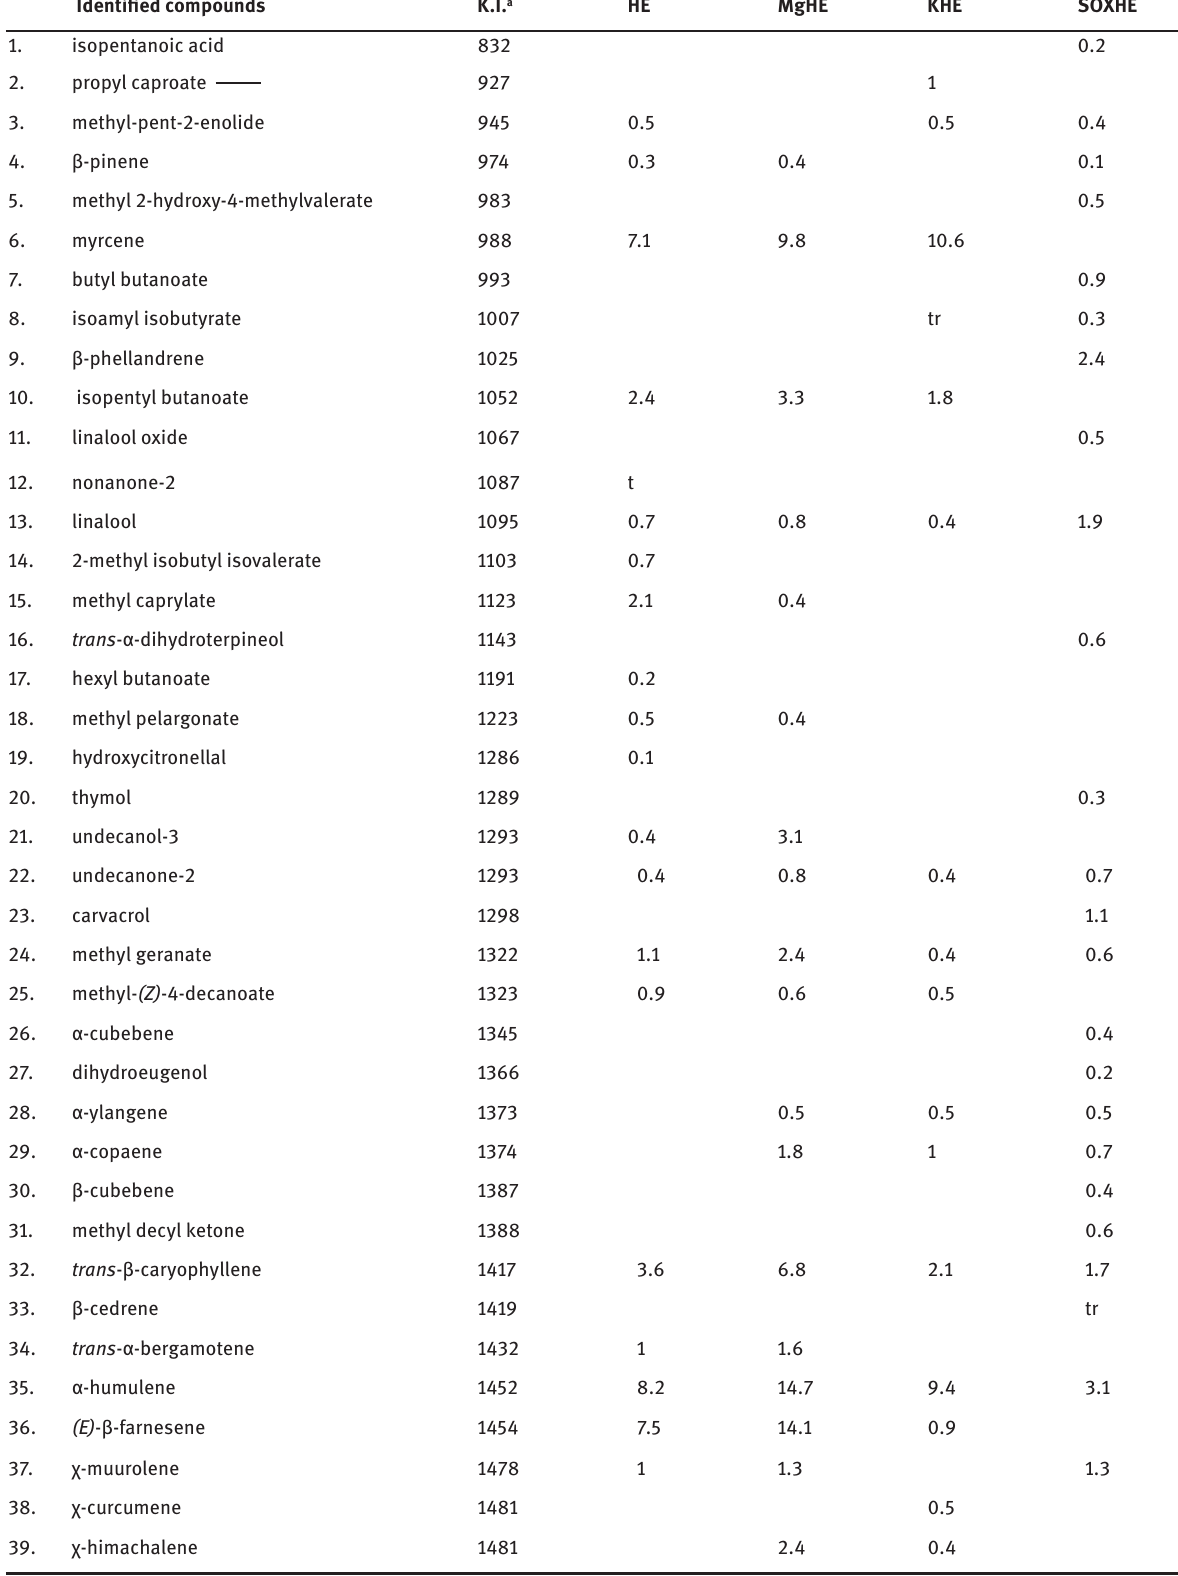
Table 3: Chemical composition achieved by GC-MS method of the investigated hops extracts. Identified